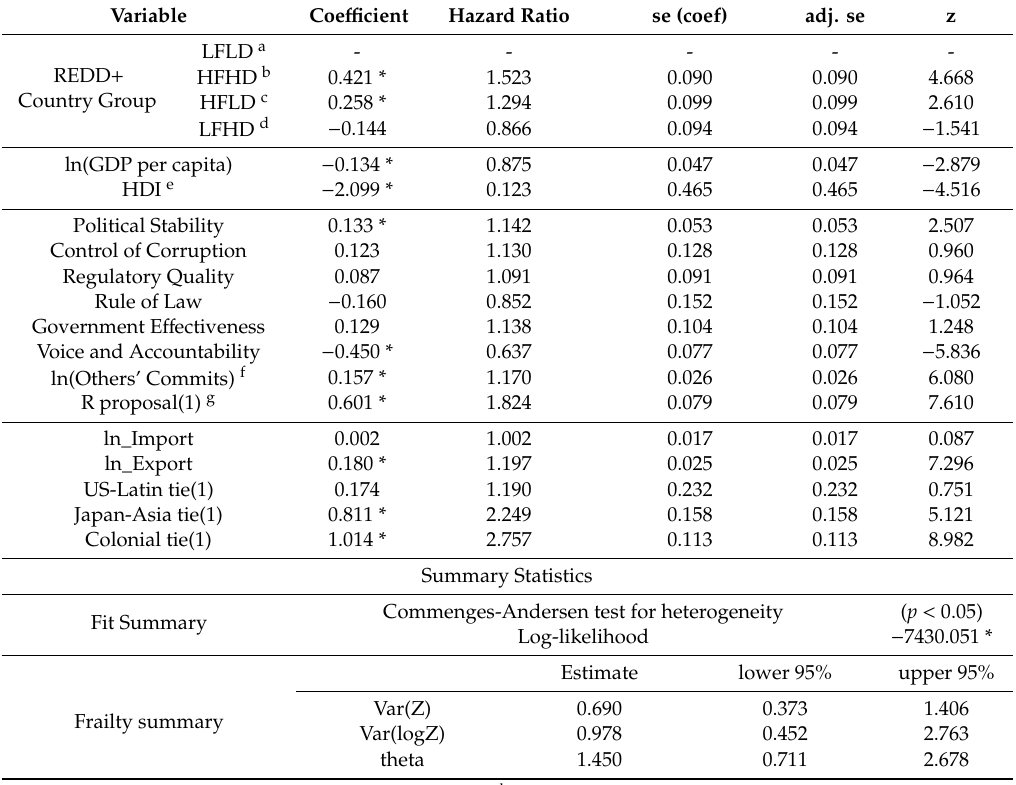
Table 6. Result of the shared frailty model for bilateral REDD + recipient country